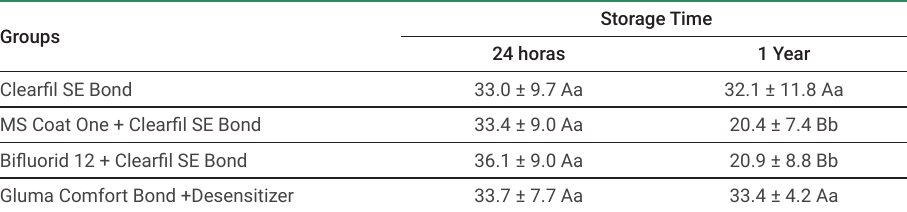
Table 2. Means and standard deviations (MPa) of µTBS for the experimental groups at 24 hours and after one year of water storage. Groups